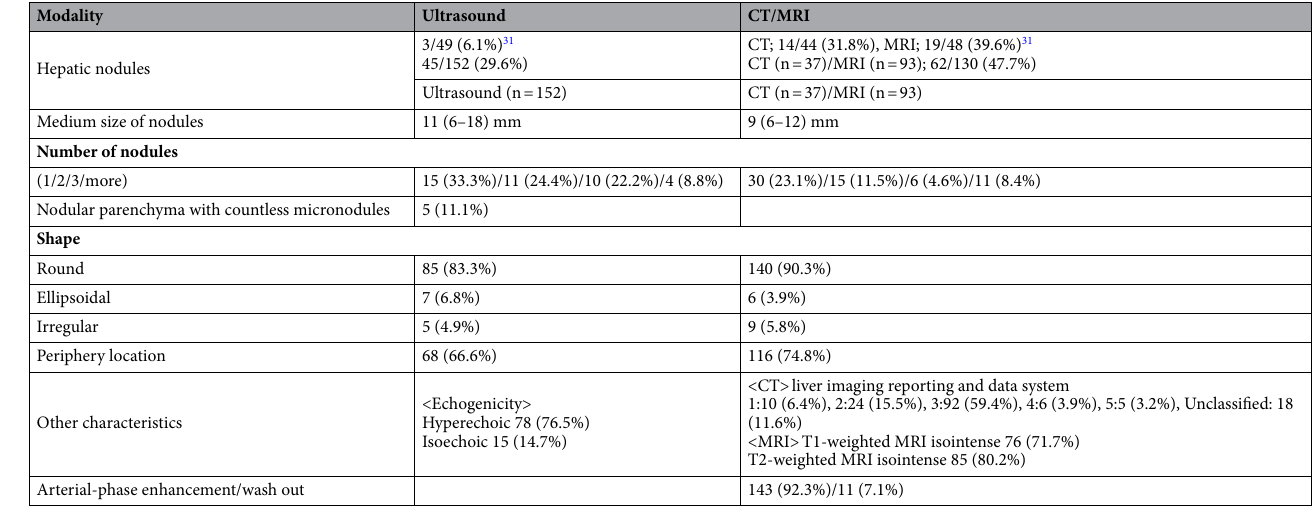
Table 3. Characteristics of liver nodules in FALD 53 . CT computed tomography, MRI magnetic resonance